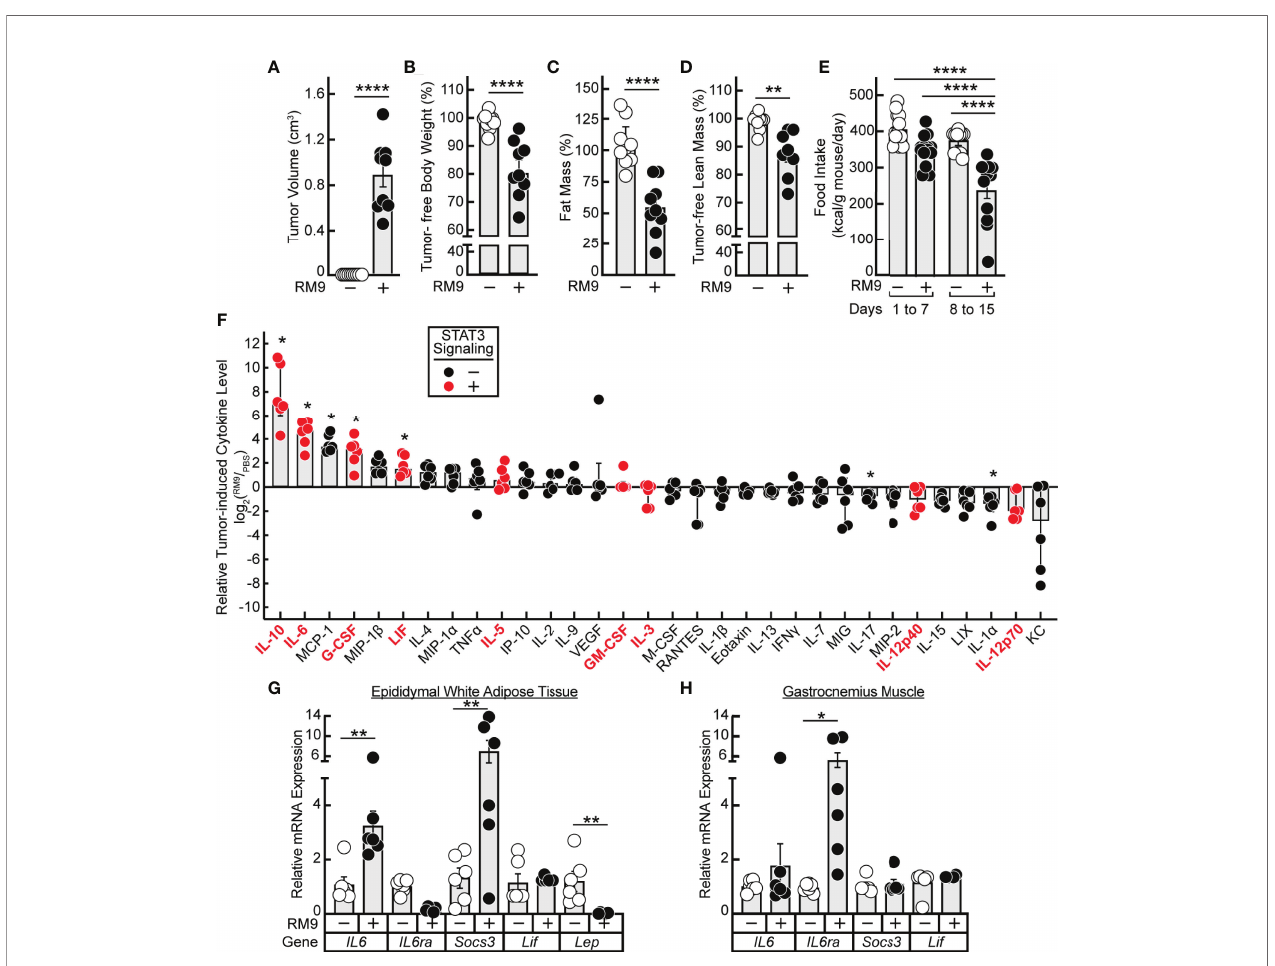
FIGURE 3 | Serum Cytokine Pro fi le of RM9 Cancer Cachexia Murine Model. (A – H) Chow-fed C57BL/6J mice (12-week old male, n=9) were injected s.c. in their right fl ank with 100 m l PBS in the absence ( open circles ) or presence ( closed circles) of 1x10 6 RM9 cells on day 0 with mice subsequently observed for 12 days. One mouse in the RM9 cohort died unexpectedly and the values of this mouse was omitted from the data. Measurements of tumor volume (A) , tumor-free body weight (B) , fat mass (C) , tumor-free lean mass (D) , and food intake (E) were obtained at sacri fi ce. Tumor-free body weight, fat mass, and tumor-free lean mass are shown relative to the average measurements of the mouse cohort that received PBS alone which were which were 27.2 g, 3.2g, and 20.1 g, respectively. Serum, epididymal white adipose tissue, and gastrocnemius muscle were harvested at sacri fi ce for evaluations of cytokine concentration (F) and gene expression by qRT-PCR (G, H) as described in Methods . Data are shown as dot plots with bars representing mean ± SEM. * p < 0.05,** p < 0.01 and **** p < 0.0001 based on two-tailed Student ’ s t-test (A – D) , two- way ANOVA with Tukey ’ s multiple comparison test (E, G, H) , or use of a ROUT method (Q = 0.01) to remove outliers followed by Mann-Whitney test with Bonferroni multiple comparison test (F) for differences between cohorts injected with PBS alone to cohorts injected with PBS in the presence of RM9